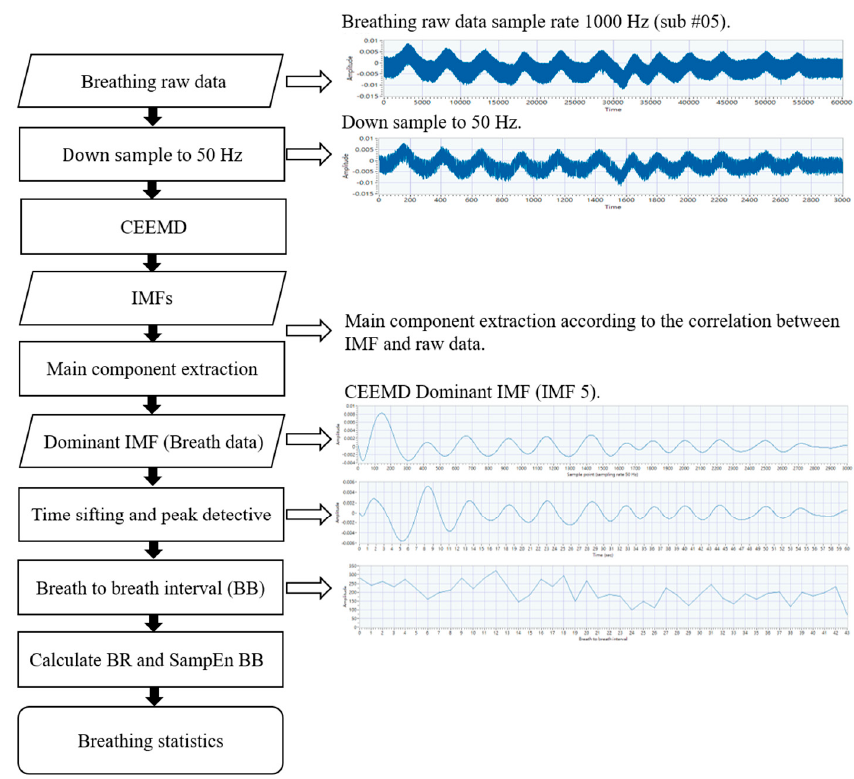
Figure 2. RIP signal processing flowchart.